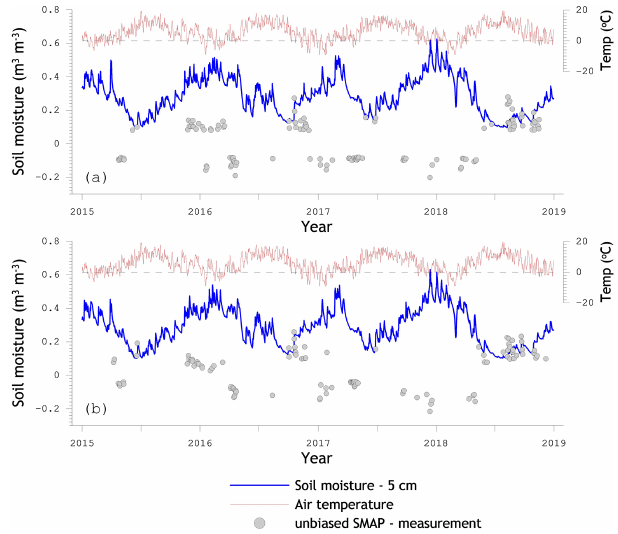
Figure 14. Time series of measured soil moisture (all-station mean), daily minimum air temperature, and unbiased differences between SMAP SCA-V retrievals for reference pixel 4371 and the all-station mean exceeding 2 σ ( > 0 . 08m 3 m − 3